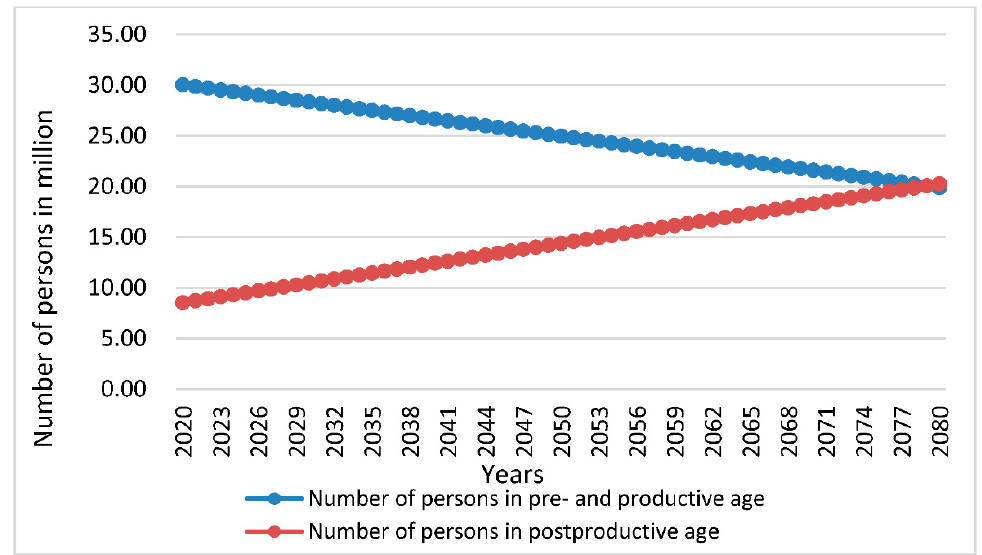
Figure 6. Official prognosis of the number of people of pre-, post-, and productive age (in thsd)